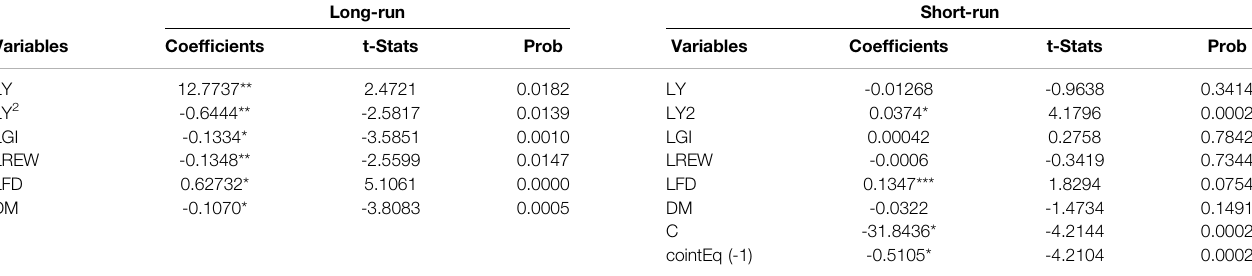
TABLE 5 | Long & short-run outcomes model